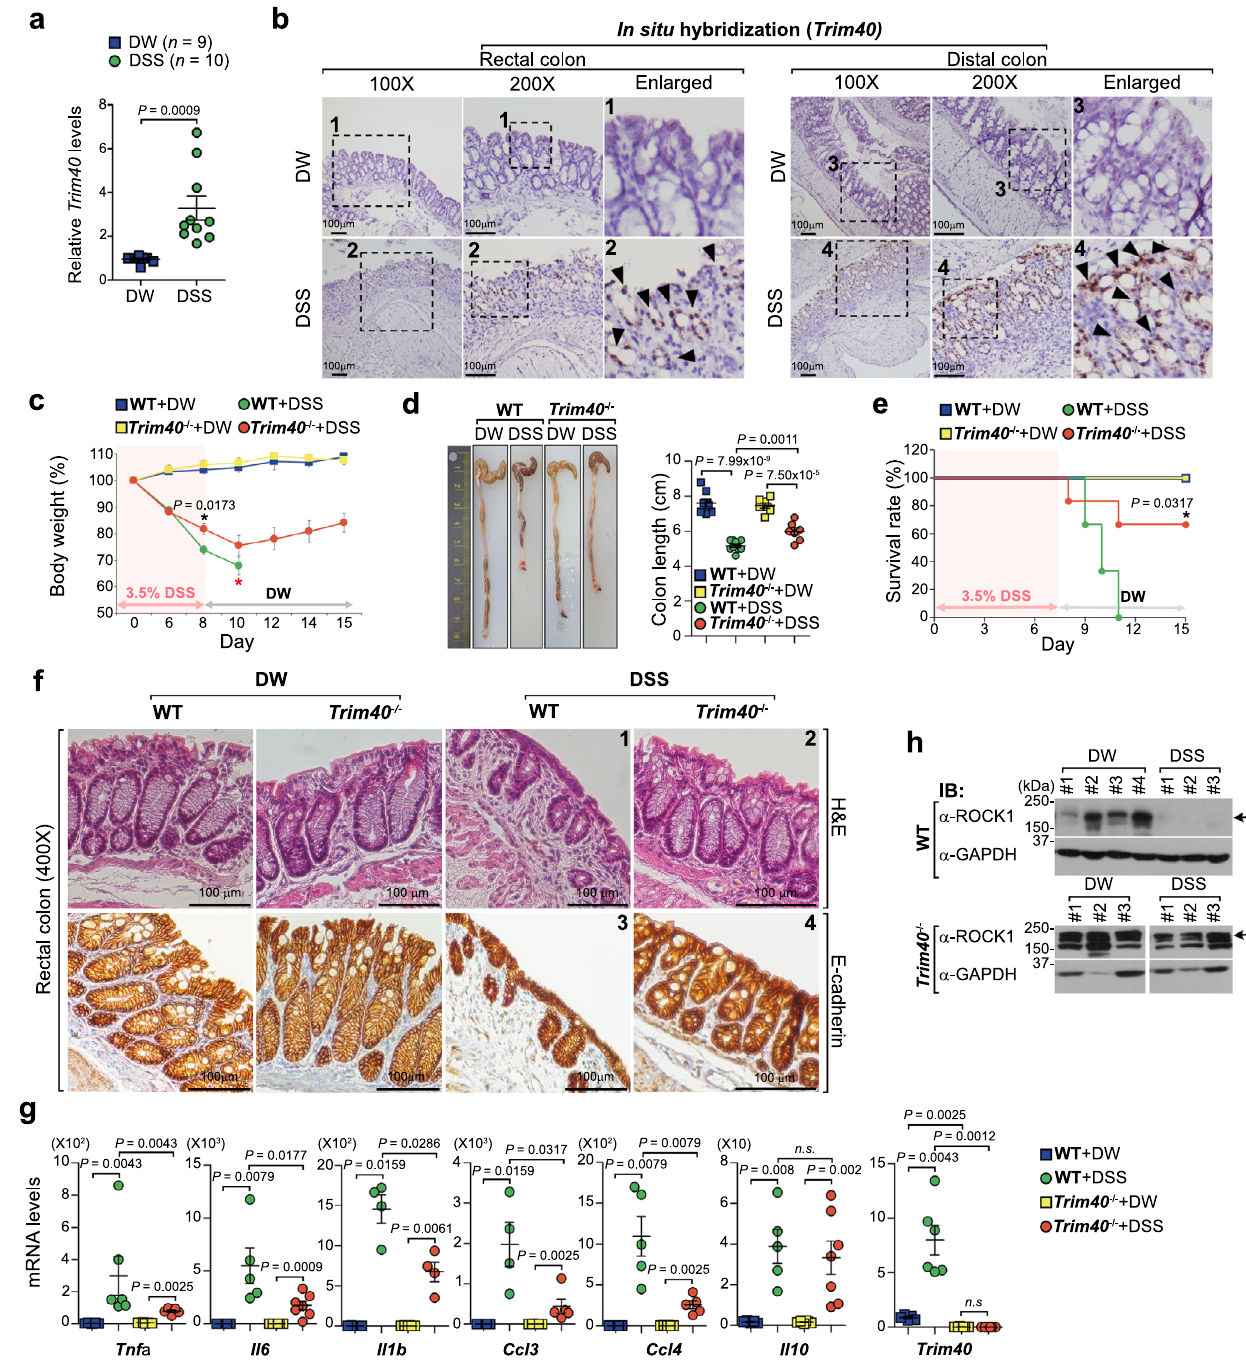
Fig. 5 | Trim40 -de fi cient mice were less susceptible to DSS-induced colitis. a qPCR showing relative mRNA levels of Trim40 in 2% DSS-induced colitis. Trim40 expressionwasanalyzedincolontissuefromWTmalemice(DW, n =9;DSS, n =10). P values are determined by unpaired two-tailed t test. ( n , numbers of mice; mean±SD). b ISH showing Trim40 mRNA levels in rectal or distal colon tissues from WT male mice with 2% DSS. Brown (black arrowheads) indicates Trim40 mRNA expression. Enlarged views of the regions are denoted by the black dashed squares(#1 – 4).Scalebars,100 μ m. c Relativelossofbodyweightinmalemicewith 3.5% DSS. WT (DW, n =3; DSS, n =6), Trim40 − / − (DW, n =4; DSS, n =6). P values are determined by unpaired two-tailed t test. ( n , numbers of mice; mean±SEM). Red asteriskindicatesthatmostcontrolmicediedwithin10daysofDSSadministration. d Images of colon length of male mice at day 7 after 2% DSS administration. WT (DW, n =8; DSS, n =10), Trim40 − / − (DW, n =7; DSS, n =7). Graph showing colon